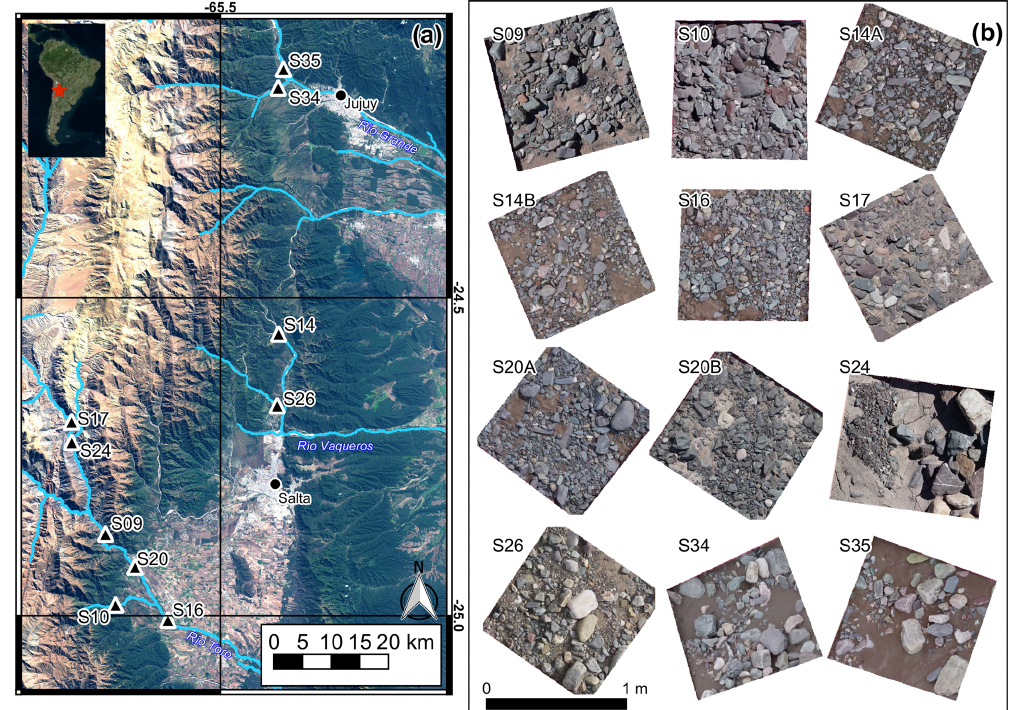
Figure 6. (a) Field cross-section survey sites (black triangles) in NW Argentina from three gravel-bed rivers (Toro, Vaqueros, and Grande) and their tributaries, draining from the sparsely vegetated mountains in the west towards the verdant foreland and city centers of Salta and Ju- juy in the east. The Landsat 8 RGB composite satellite image (using bands 2, 3, and 4) from 12 June 2017 shows the climatic transition from wet foreland to dry mountains, demarcated by the green–brown transition zone, running approximately north–south, corresponding to vegeta- tion changes. (b) Detailed view of the 12 × ∼ 1m 2 orthomosaic clips from each of the field sites with average resolution of 1.16mmpixel − 1 .